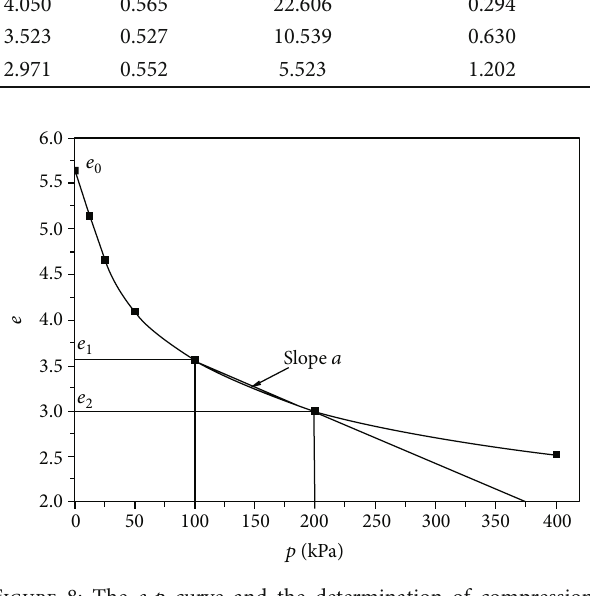
Figure 8: The e ‐ p curve and the determination of compression coe ffi cient a of soil. v